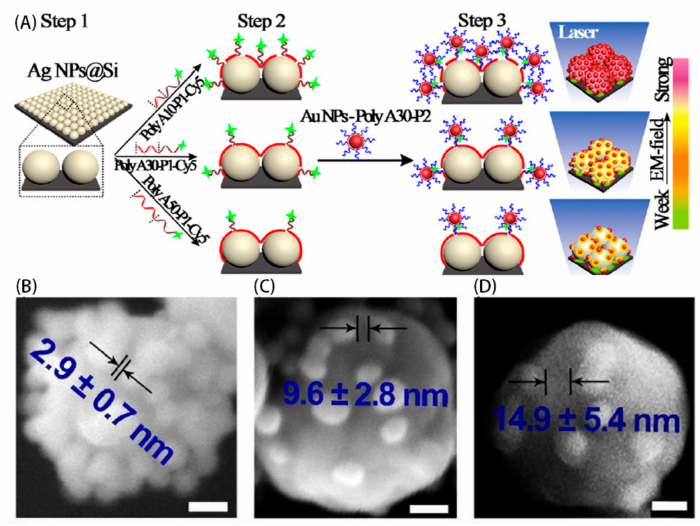
Figure 6. ( A ) A polyadenine mediated core-satellite nanoassembly immobilized on the silicon wafer [66]. ( B – D ) are SEM images of the interparticle gaps of satellite Au NPs of Au-Au NPs mediated by Poly A10, Poly A30, and Poly